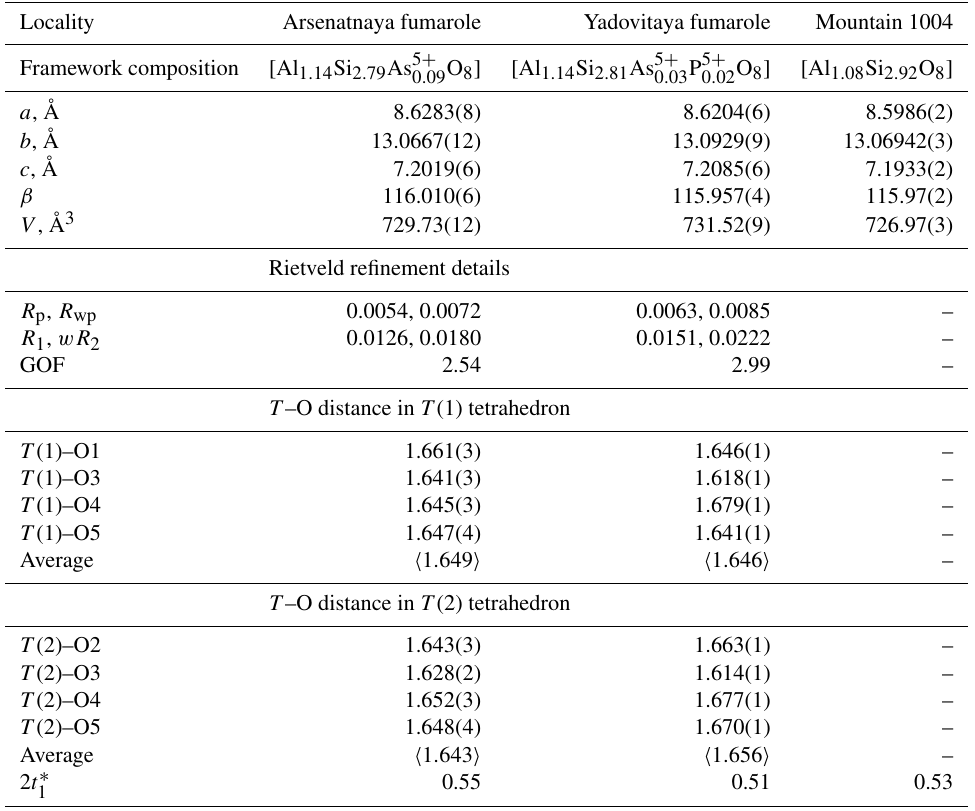
Table 2. Unit-cell parameters and T –O ( T = Si, Al, As) distances (in ångströms) in the crystal structure of sanidine from active fumaroles Arsenatnaya and Yadovitaya and ancient fumarole at the Mountain 1004.